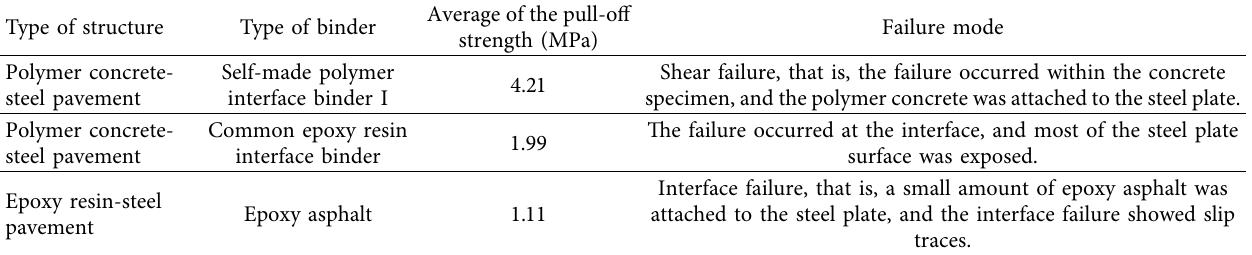
Figure 7: Pull-off failure of steel plate-polymer-modified cement lattice concrete interface formed by different interfacial binders. (a) Self- made polymer-bonded steel interface, (b) common epoxy resin, and (c) epoxy asphalt. Table 4: Interface shear test results for different interface binders.